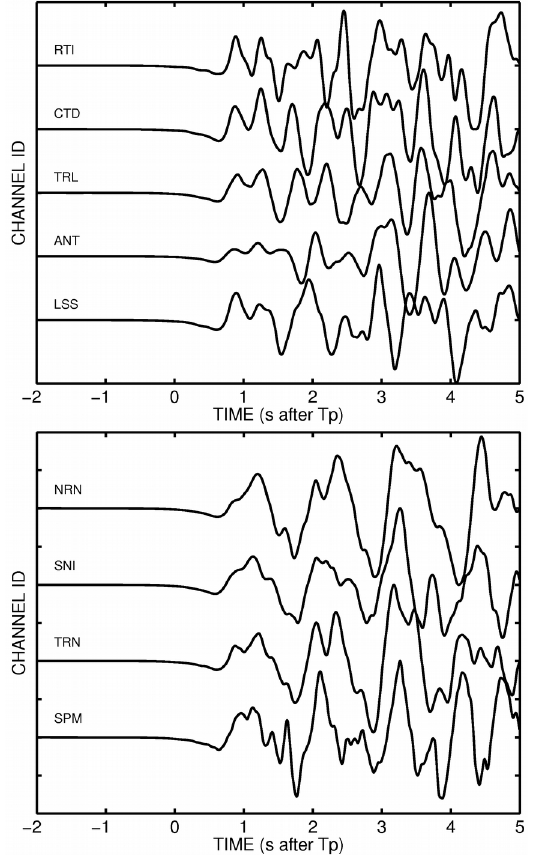
Figure 2 – Vertical­component velocity seismograms from strong­motion accelerometer sub­arrays AR1 (top) and AR2 (bottom), whose location is shown in Fig. 1. Data are band­pass filtered within the 0.5­4Hz frequency band and aligned to the P­wave